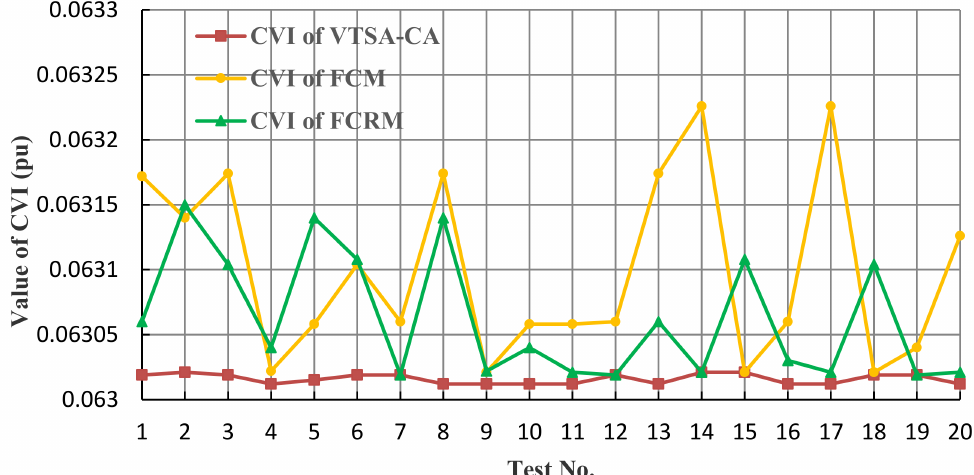
Figure 3. Clustering precision comparison of Iris data sets.